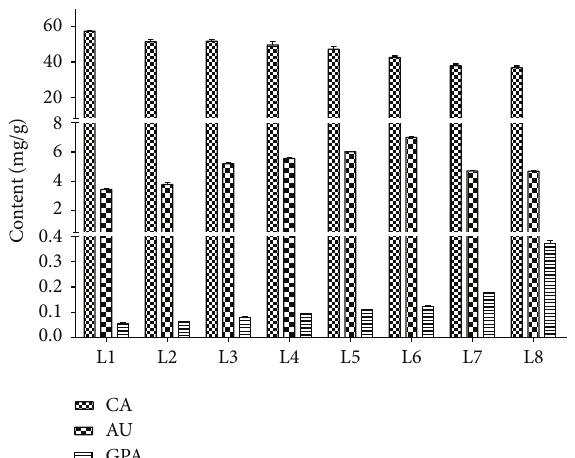
Figure 5: Content of catalpol, aucubin, and geniposidic acid in different developmental stages of Wen 85-5 leaves.